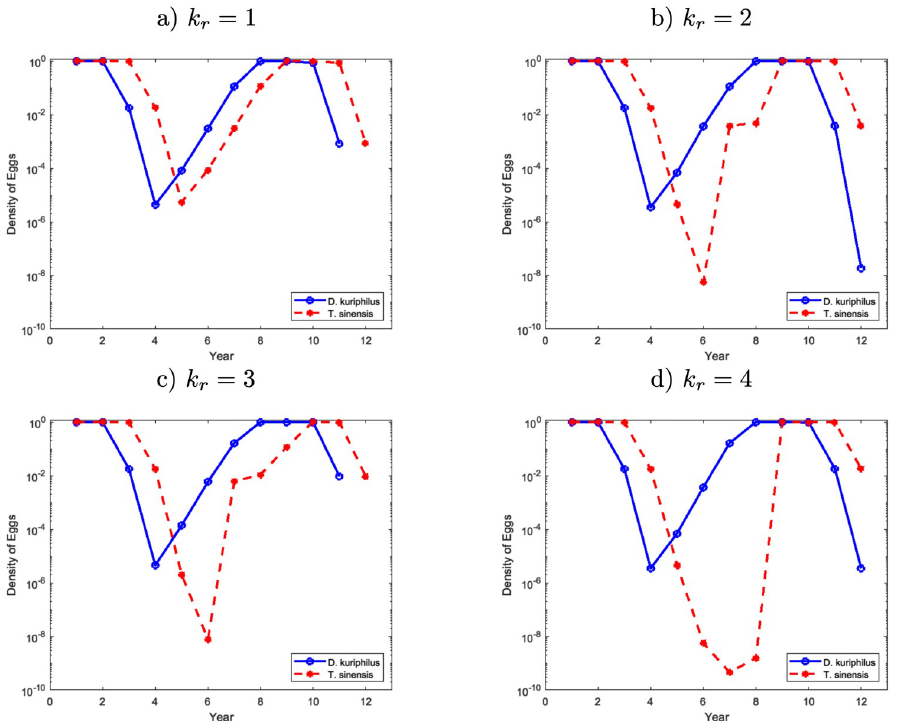
Fig 9. Egg density of D . kuriphilus ( v release of T . sinensis made simultaneously with periodicity k r according to a regular mesh 4 × 4.